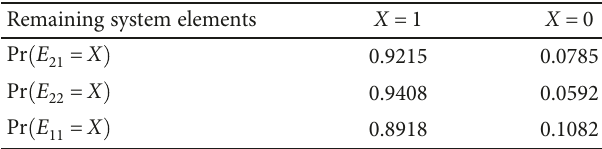
Table 4: Calculated remaining element